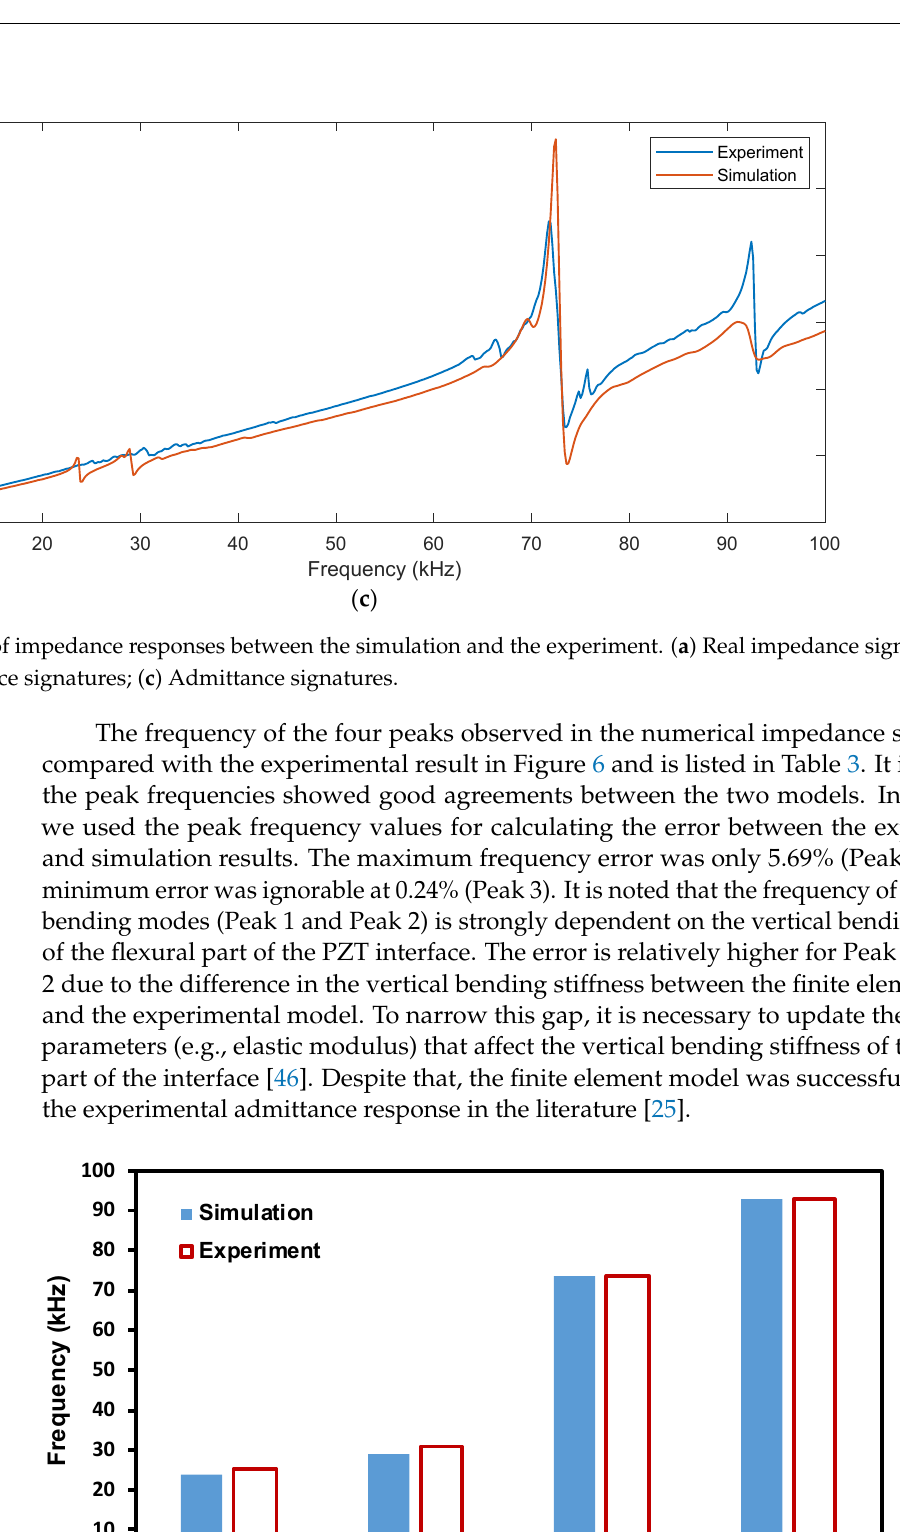
Figure 6. Comparison of peak frequencies between the numerical simulation and the experiment.